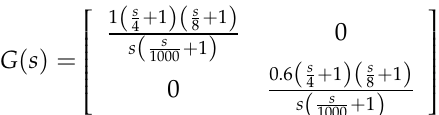
Table 1. Tracking feedforward controller and pure feedback controller ( G fb ).